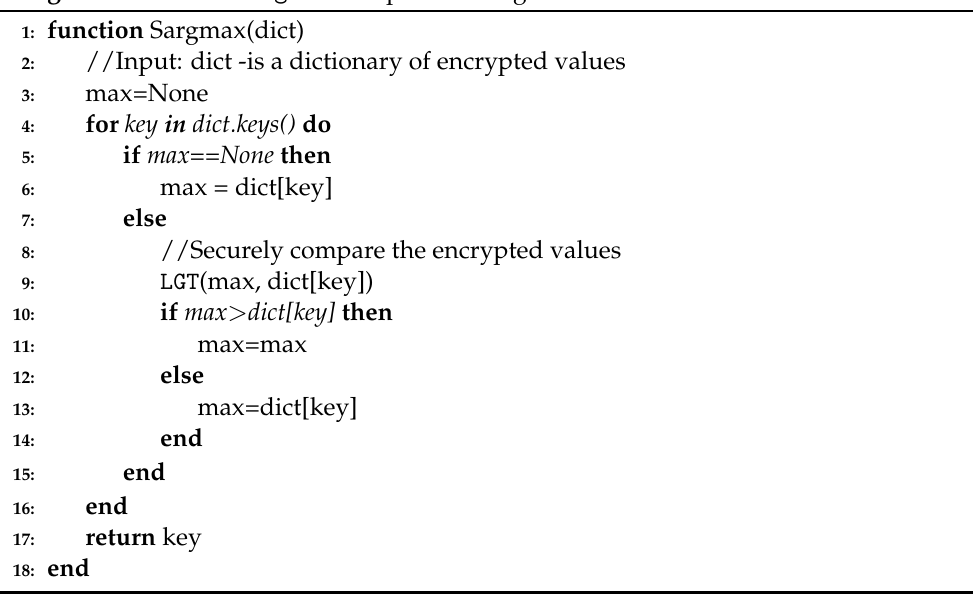
Algorithm 1: Secure argmax Computation